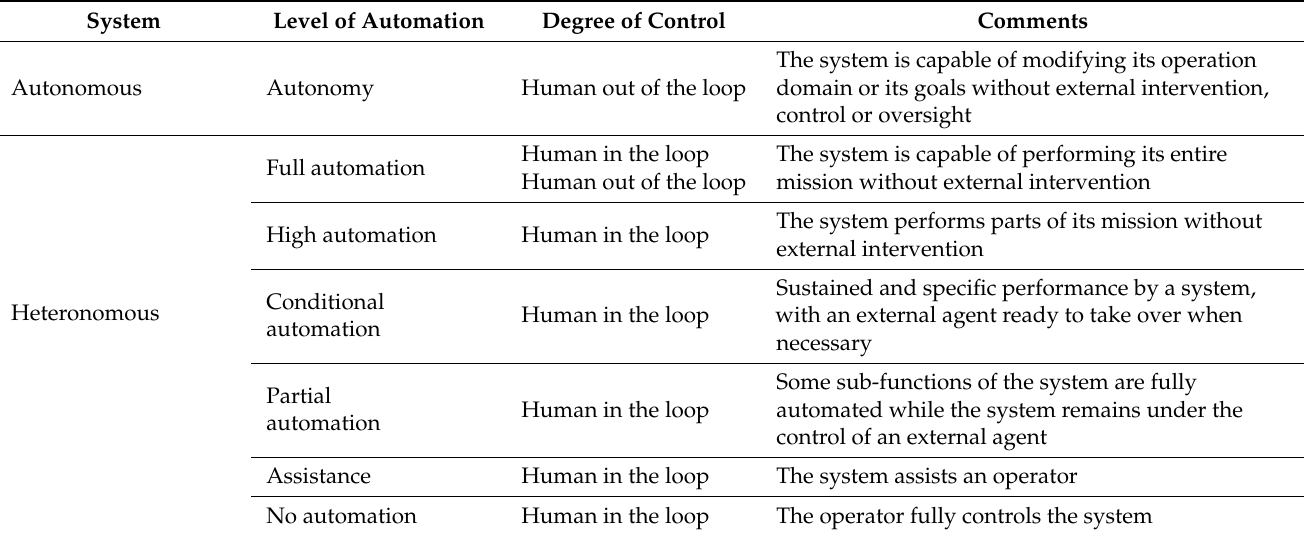
Table 1. Description of the seven degrees of automation [4]: no automation, assistance, partial automation, conditional automation, high automation, full automation and